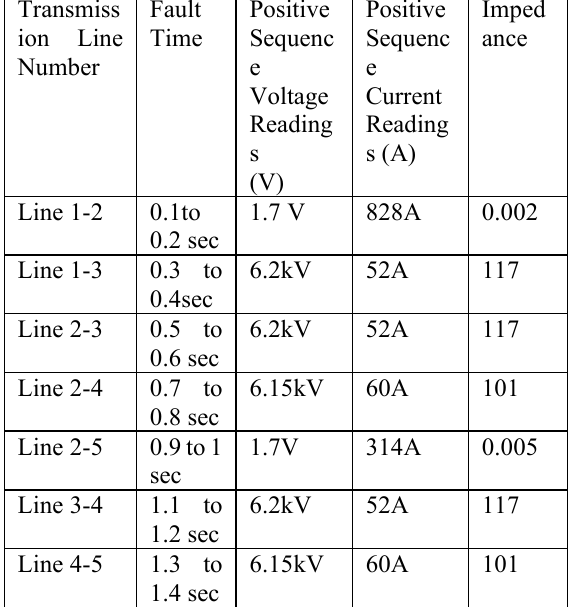
Fig.10 Voltage waveform recorded by PMU from BUS2